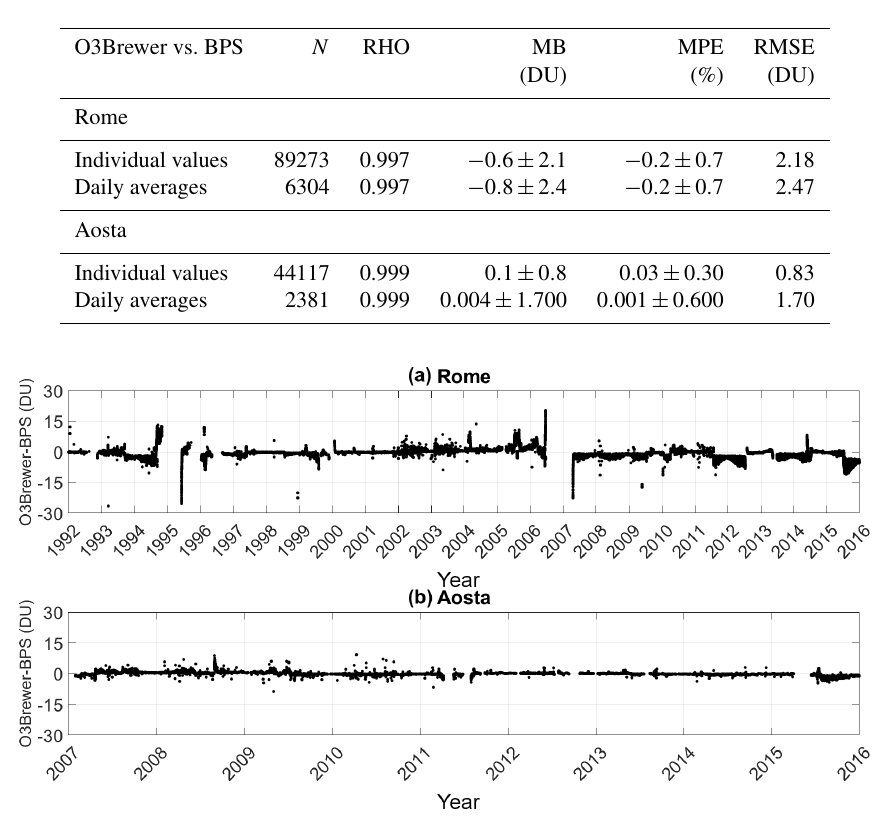
Table 3. Summary of the statistics of O3Brewer vs. BPS at both sites (N: number of data; RHO: Spearman scaled correlation coefficient; MB: mean bias; MPE: mean percentage error; RMSE: root mean square error; the uncertainty of MB and MPE is characterized by the standard deviation).